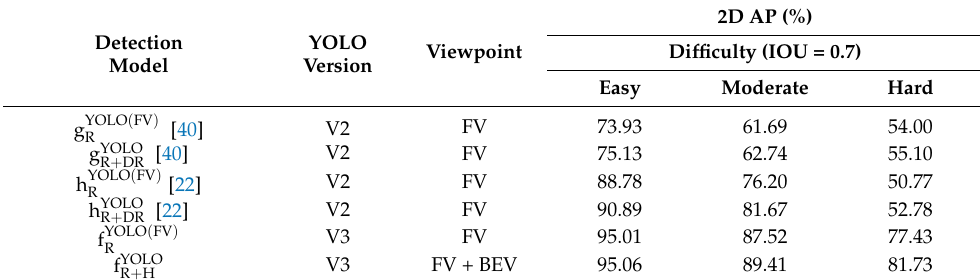
Table 2. Comparative evaluation according to difficulty